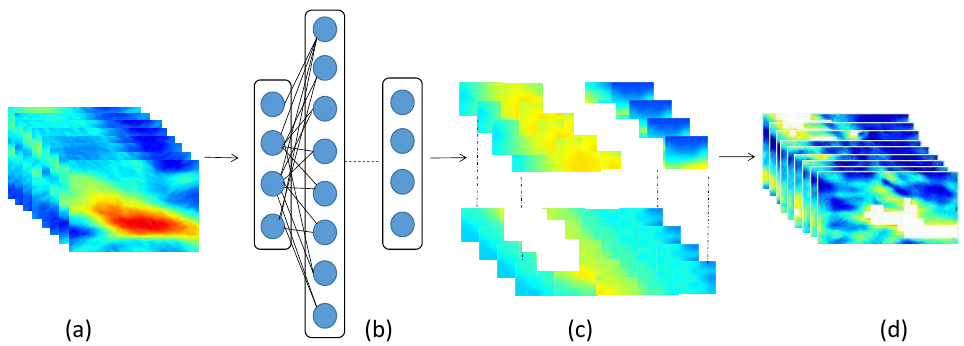
Figure 9. The ocean-front tracking algorithm. Firstly, the images ( a ) are sent to the GoogLeNet Inception network ( b ) to perform classification. The foreground images are changed to white, and the background image blocks remain unchanged ( c ). Finally, the images are used to reconstruct the video sequence ( d